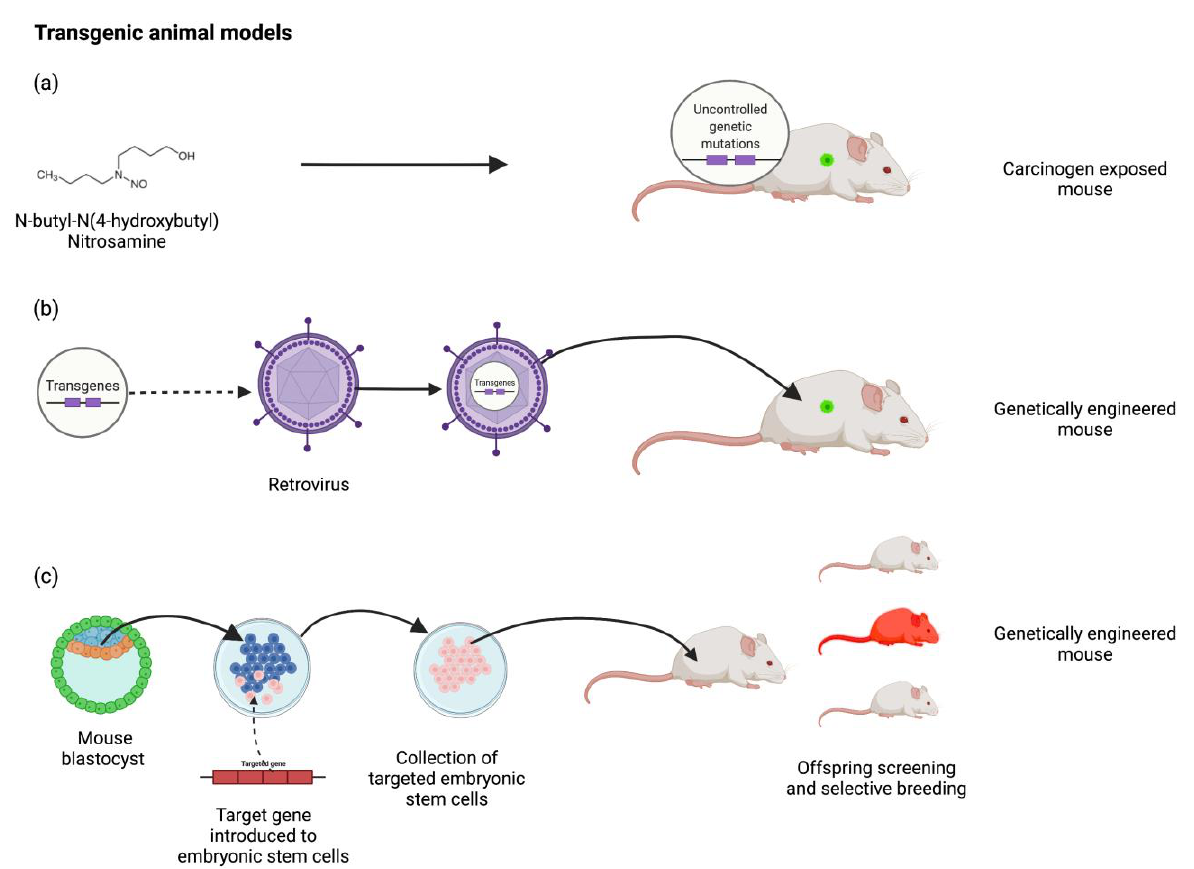
Figure 2. Examples of transgenic animal models. ( a ) Carcinogen exposed mouse (e.g., nitrosamine), ( b ) gentetically engineered mouse by retrovial infection and ( c ) gentetically engineered mouse by gene-targeted transgene approach via genetic manipulation of embryonic stem cells. Created with